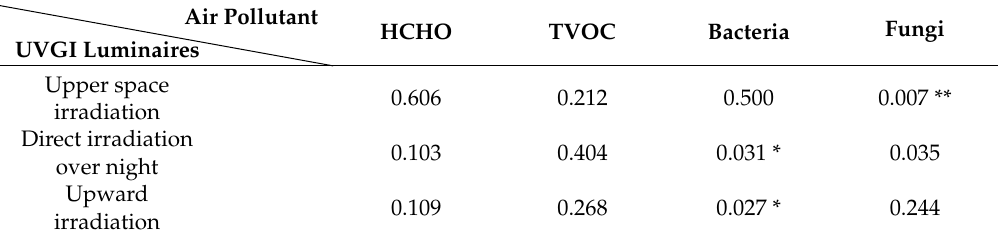
Figure 7. Efficiency of microbiological air pollutants: ( a ) Bacteria and ( b ) fungi removal by varying UVGI irradiation methods. Table 4. Student’s t-test (two sample unequal variance) for various irradiation